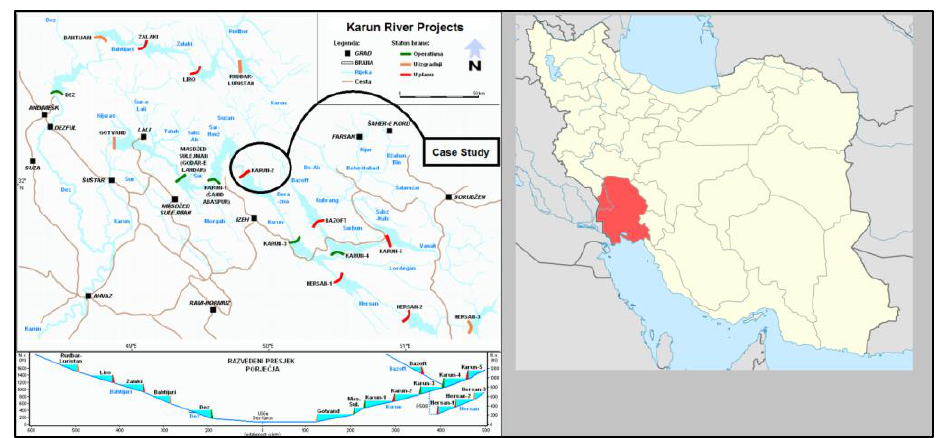
Figure 1. Location of Karun II in among all projects of Karun